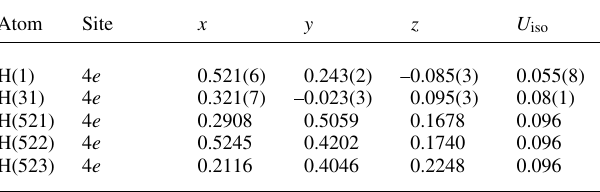
Table 2. Atomic coordinates and displacement parameters (in Å 2 )